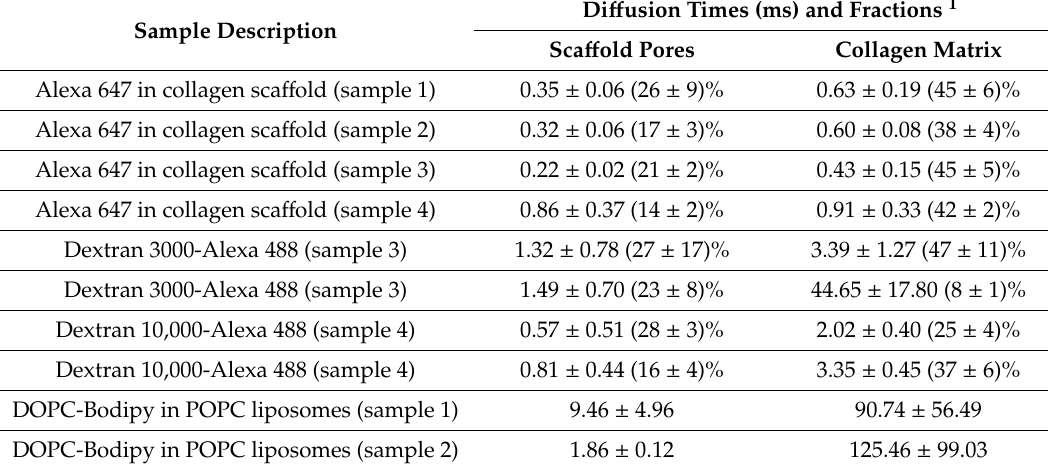
Table 1. Di ff usion times measured in collagen sca ff olds using fluorescence correlation spectroscopy. The results obtained in the pores and in the collagen matrix are